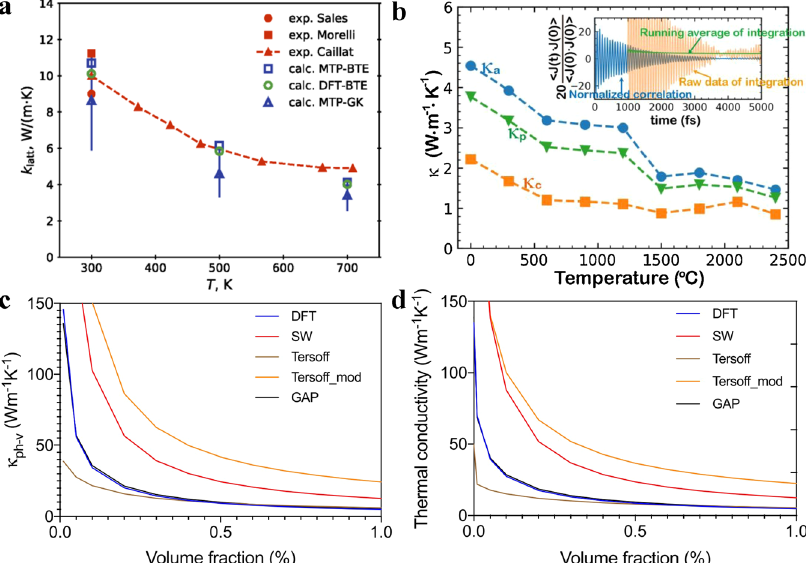
Fig. 6 Accurate prediction of lattice thermal conductivities by utilizing machine learning potentials. a Comparison of the calculated and experimentally measured κ L of CoSb 3 . The vertical lines show doubled standard deviation of the results calculated by Green-Kubo method. Reproduced with permission from ref. 68 . b The lattice thermal conductivities along two different directions ( κ a and κ c ) and their average value ( κ p ) of (Ti 0.2 Zr 0.2 Hf 0.2 Nb 0.2 Ta 0.2 )B 2 , which are plotted as a function of temperature. The inset shows the auto-correlation function. Reproduced with permission from ref. 107 . c κ ph-v and d κ 3ph + ph-v of silicon with respect to vacancy concentration at 300 K, predicted by the DFT, GAP, and empirical potentials. Reproduced with permission from ref. 116